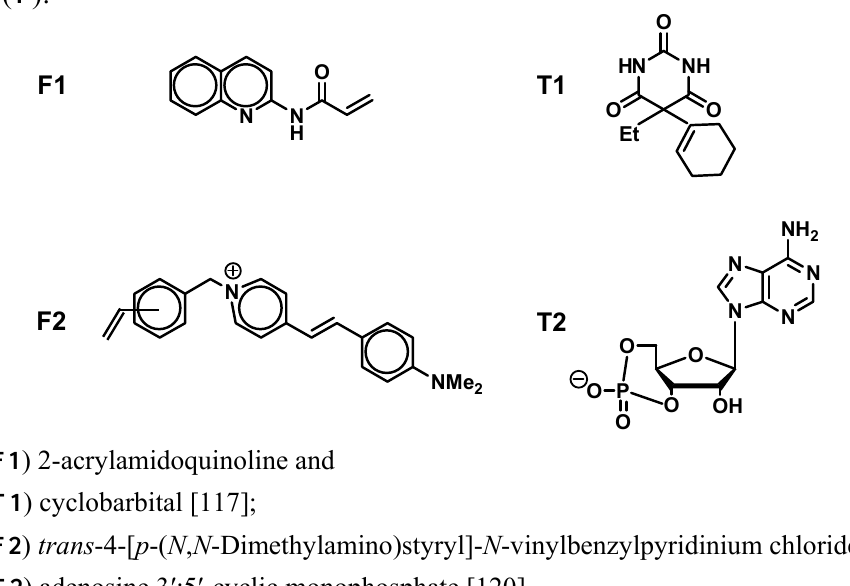
Figure 7. Fluorescent functional monomers ( F ) and their corresponding template molecules ( T